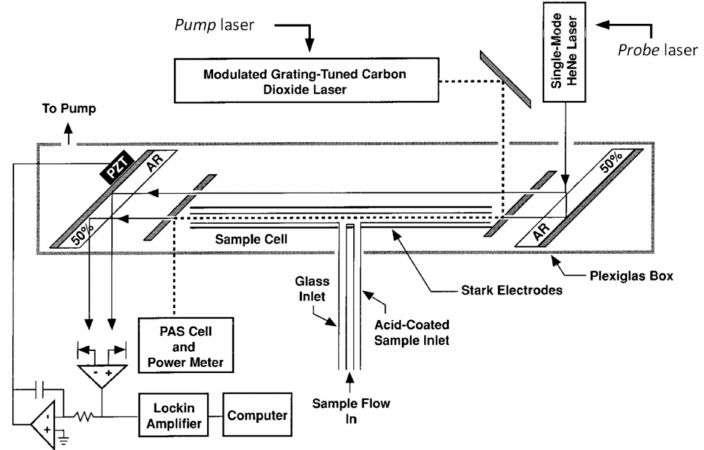
Figure 3. Schematic diagram of the unfolded Jamin interferometer PT ammonia detector. A single-mode He-Ne laser is used to form the interferometer. A 7 W modulated CO 2 laser beam is used as the pump source. Laser beam and gas interaction path length is 38 cm. Reprinted with permission from